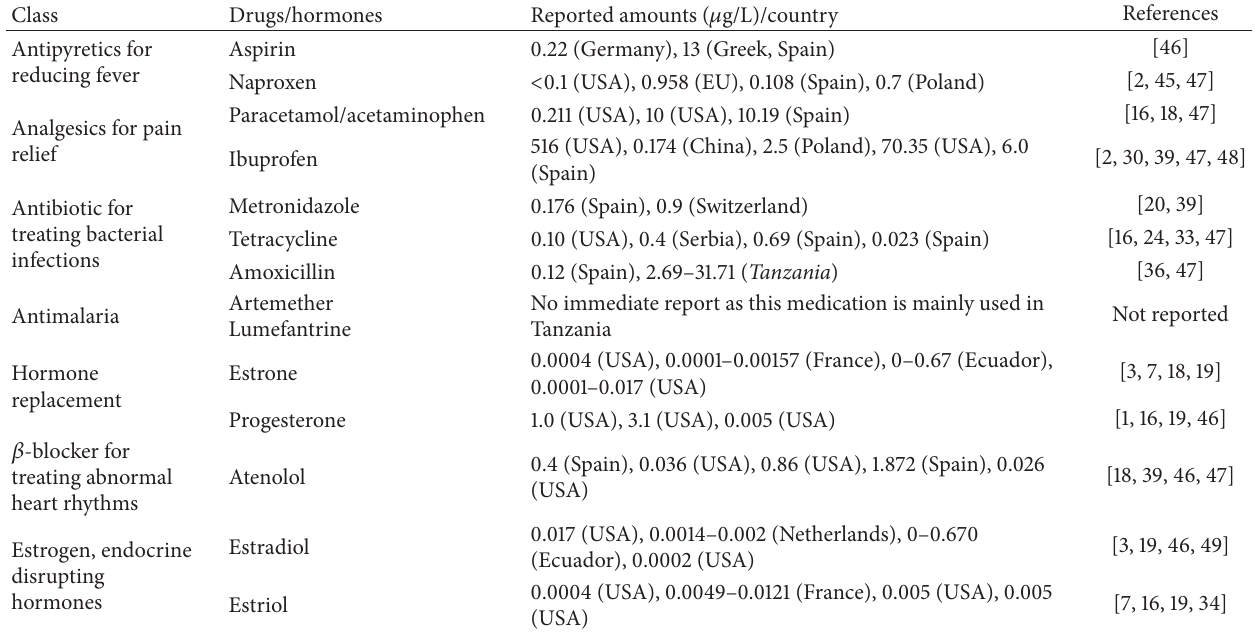
Table 1: Pharmaceuticals and endocrine disrupting